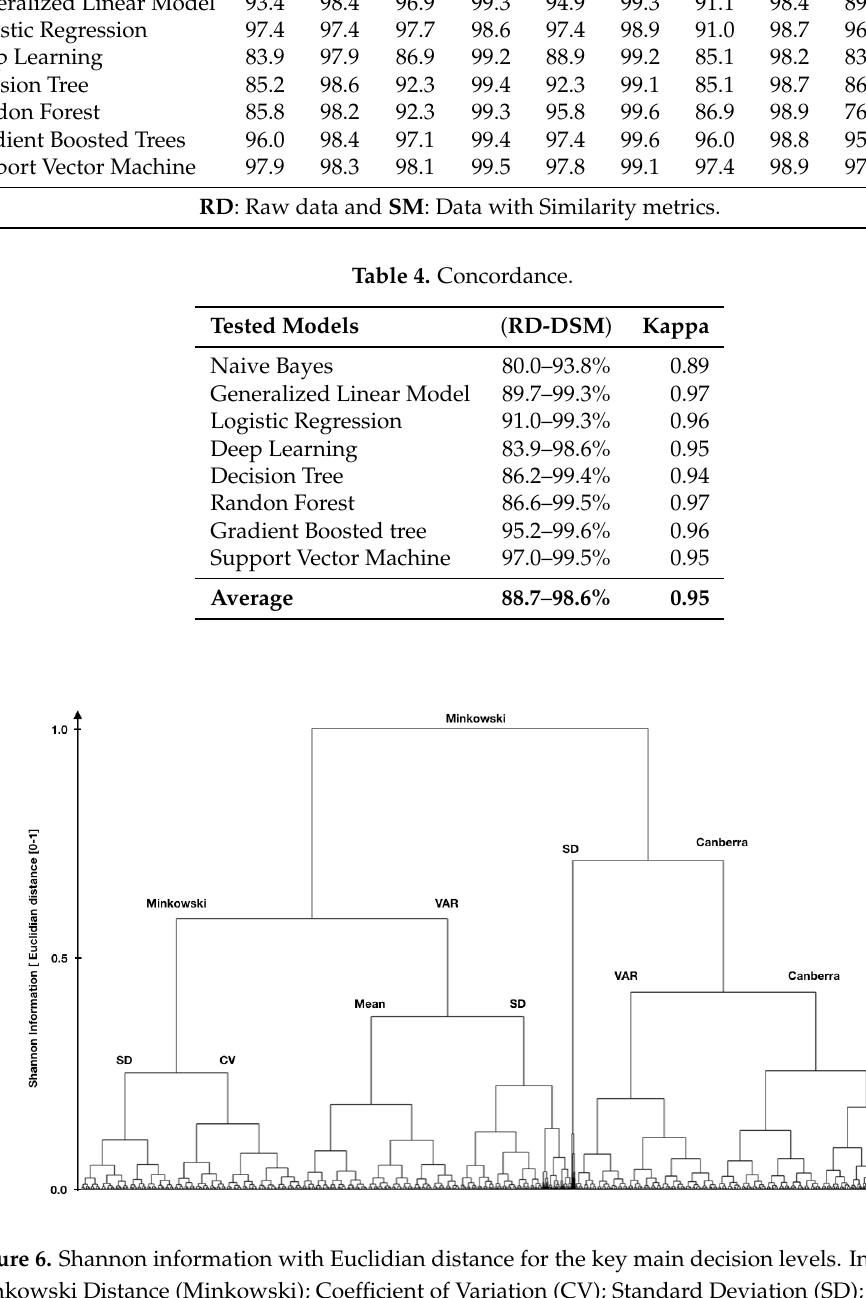
Figure 6. Shannon information with Euclidian distance for the key main decision levels. In this case: Minkowski Distance (Minkowski); Coefficient of Variation (CV); Standard Deviation (SD); Canberra distance (Canberra); Mean value